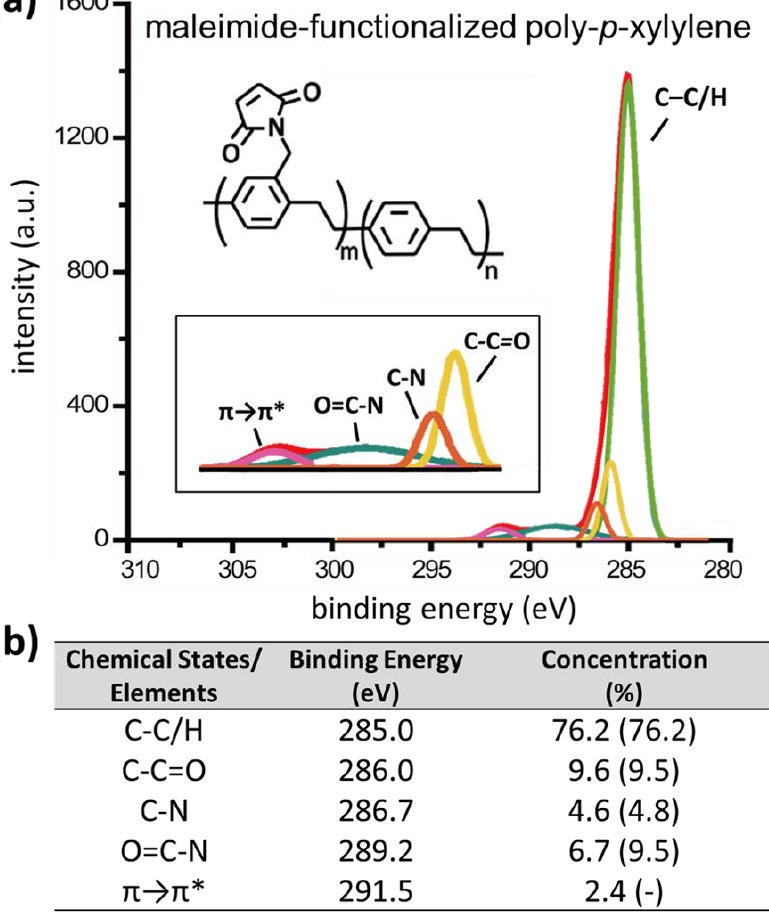
Figure 5. ( a ) X-ray photoelectron spectroscopy (XPS) high-resolution analysis shows the recorded spectra of the fabricated porous maleimide-functionalized poly- p -xylylene. Details of the decon- volution spectra showing components with respect to a specific binding energy, including C-C=O, C-N, O=C-N, and π → π * transition bonds, are indicated in the enlarged image. ( b ) Detailed chemical compositions were confirmed by comparing the binding energies of the expected chemical states for the experimental values with the theoretical values (in brackets).